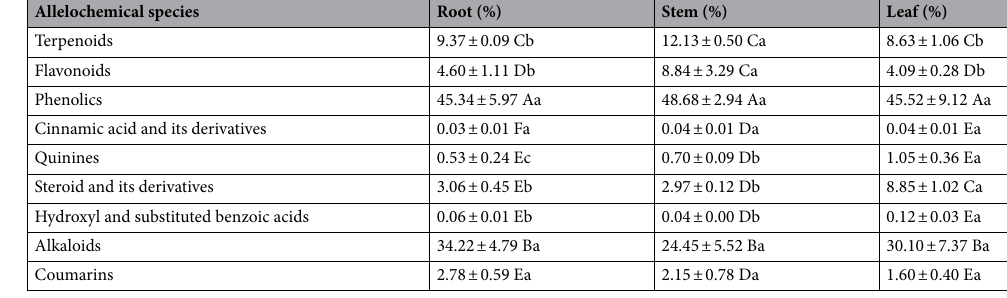
Table 4. Relative content of allelochemicals in the aqueous extracts of sesame. Different capital letters of in the same column indicated significant differences among different allelochemical species at P < 0.05 level, and different lowercase letters of in the same row indicated significant differences among different organs at P < 0.05